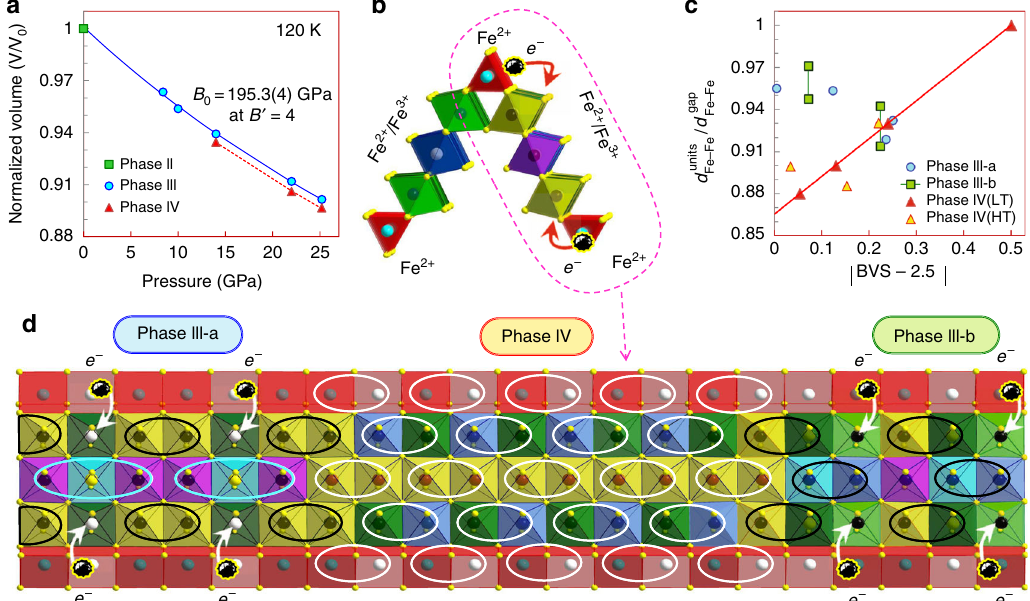
Fig. 7 Pressure-driven Fe 4 O 5 -III → Fe 4 O 5 -IV transition. a Equation of state of Fe 4 O 5 at 120 K showing a volume drop of ~0.5% at the Fe 4 O 5 -III → Fe 4 O 5 -IV transition. b Edge-shared diagonal ribbons of prisms and octahedra (seen in Figs. 4 – 6) provide channels for charge hopping between the prisms and octahedra. c Correlation between ratios of Fe – Fe distances in dimers and trimers to those in gaps between them d units bond valence sums (BVS) values of iron in these chains from 2.5 + . d Model demonstrating the coexistence of several charge-ordered phases in a single crystal of Fe 4 O 5 . The electron transfer from the prisms to octahedra leads to a short-range reorganization of ordering